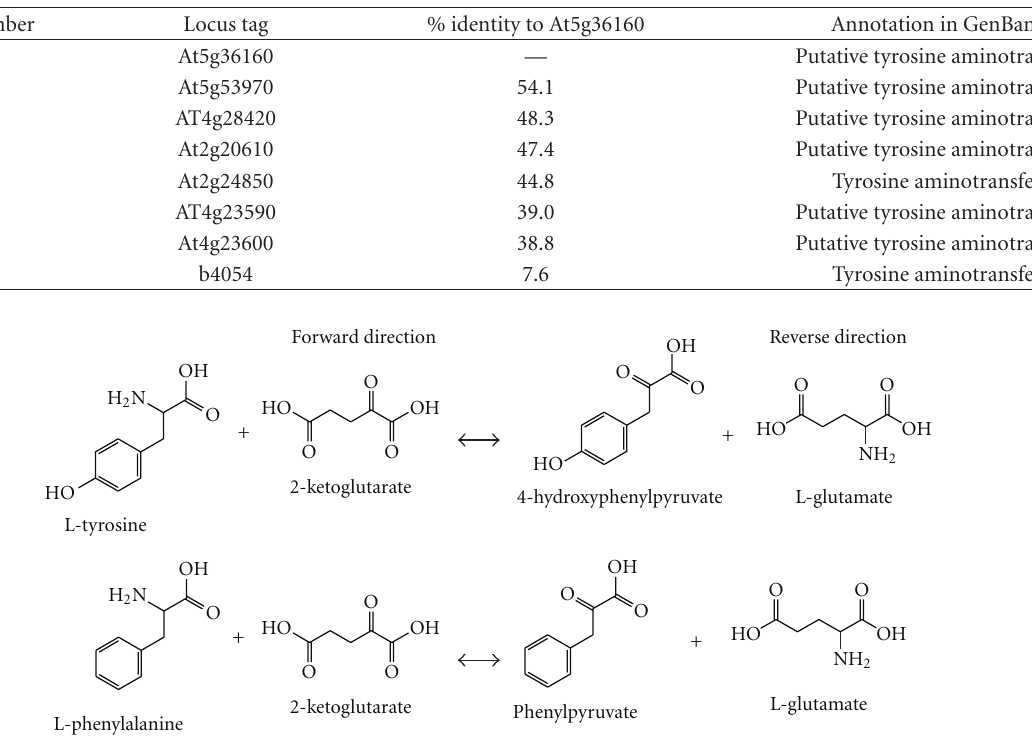
Figure 4: Reactions catalyzed by TATs. Reactions catalyzed by the enzyme in the forward and reverse directions. In the forward direction, L-Tyrosine and L-Phenylalanine serve as the amino donors while 2-ketoglutarate serves as the acceptor. In the reverse direction, glutamate serves as the amino donor while 4-hyrdroxyphenylpyruvate and phenylpyruvate serve as the acceptors.